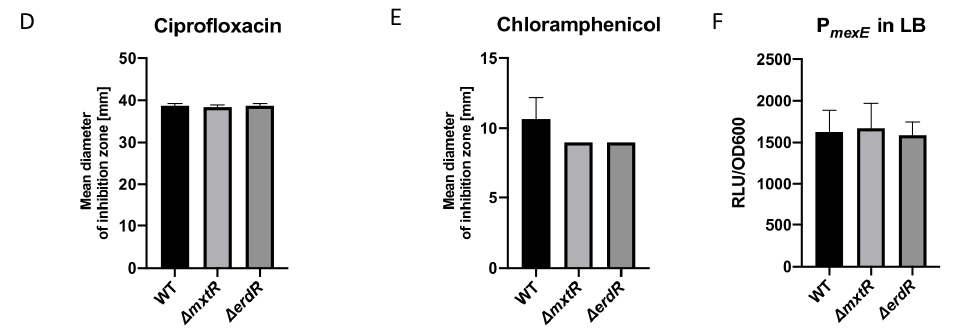
Figure 2. Effect of Δ mxtR and Δ erdR deletion in pyoverdine production and MexEF-OprN transporter in P. putida. Colony morphology assay was performed spotting 10 ul of the overnight culture into LB ( A ) and cetrimide ( B ) plates. After overnight incubation, plates were visualized and photographed under visible and UV light. The luciferase assay was performed by using WT, Δ mxtR , Δ erdR strains transformed with a plasmid containing the promoter region of the pvdL ( C ) and mexE ( F ) genes cloned upstream of the luxCDABE operon. The strains were grown in LB (similar to the conditions used in the work of Zaoui and colleagues [14]) in a ClarioStar reader and the Light Intensity and OD 600 was measured every 30 min and used for normalization (data from hour number 8 of the growth curve). Susceptibility assays against ciprofloxacin ( D ) and chloramphenicol ( E ) were made through a disk diffusion method. After 18 h incubation, the inhibition zone was measured with a ruler. All the experiments were carried out at least three times.